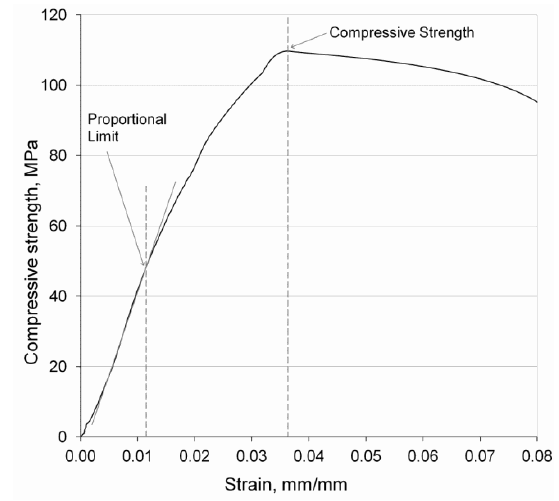
Figure 6. Stress-strain diagram of the MP Ti–6Al–4V microspheres sintered at 1400 °C for 2 h.